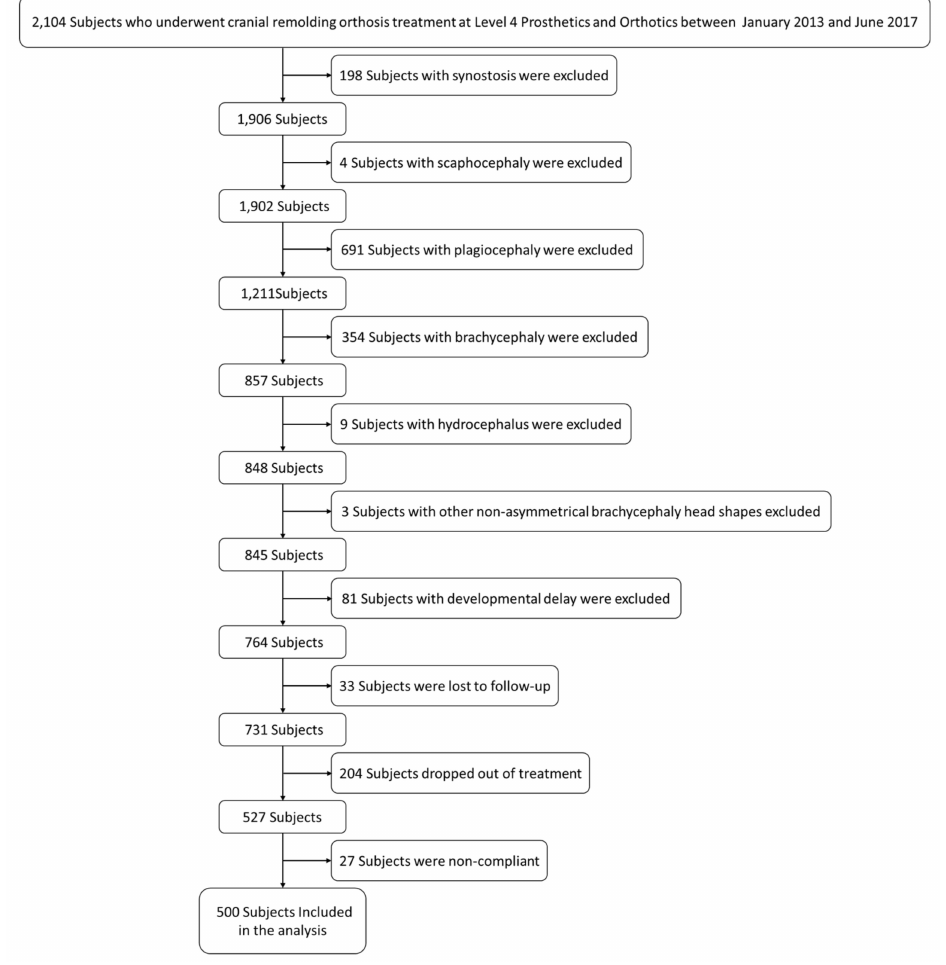
Figure 2. Flowchart showing the reduction from 2104 subjects to the 500 subjects included in the analysis based on the study inclusion and exclusion